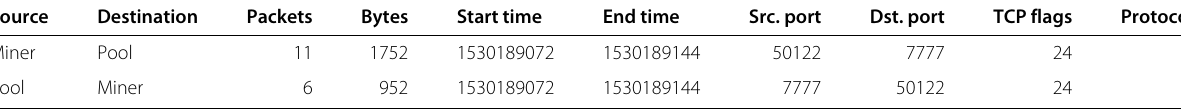
Table 1 NetFlow records corresponding to the traffic window depicted in Fig. 2